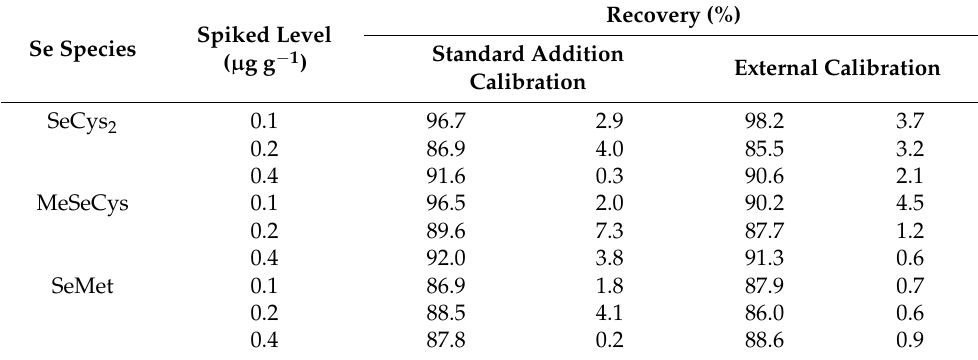
Table 2. Spike recoveries of Se species quantified by standard addition calibration and external calibration ( n =